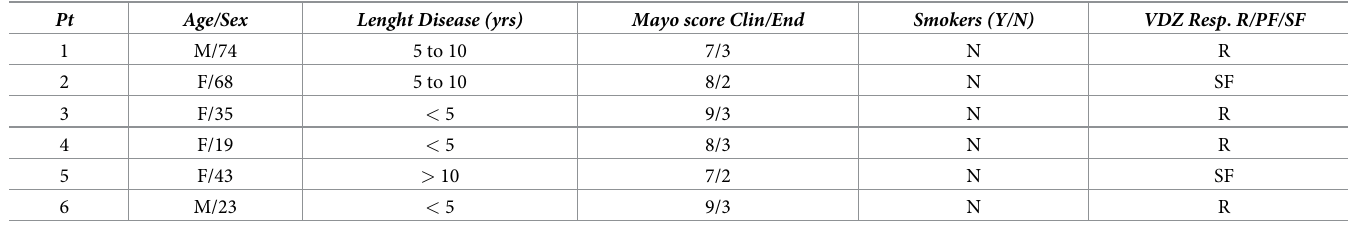
Table 2. Baseline characteristics of the IBD patients na ï ve to TNF- α